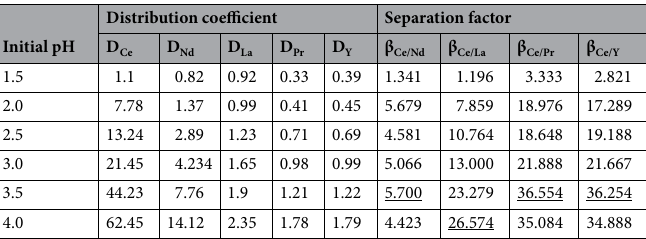
Table 4. Distribution coefficients and separation factors of cerium and other rare earths. Significant values are in underline.